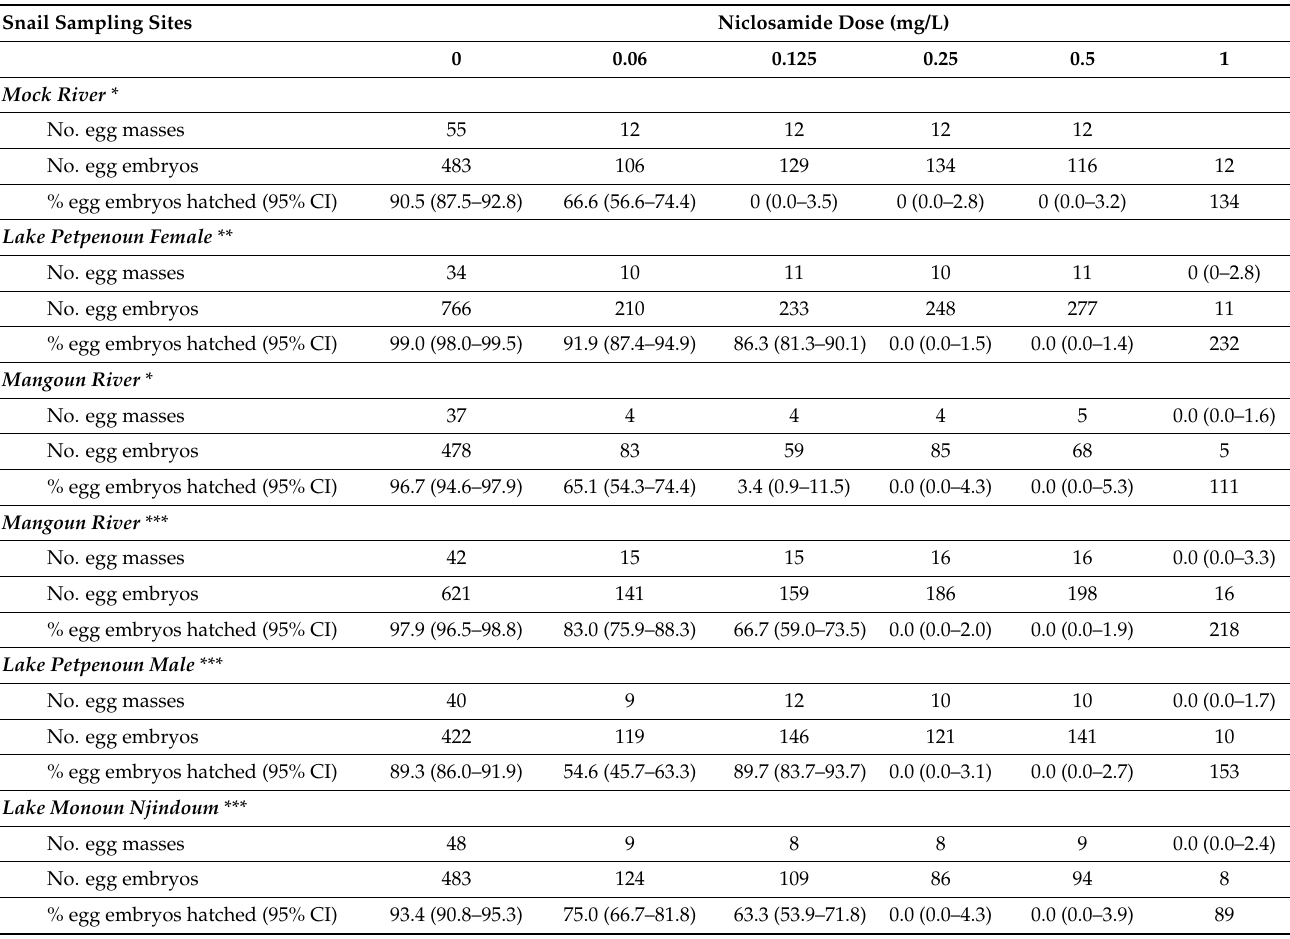
Table 1. Effect of different Niclosamide (Bayluscide WP 70) concentrations on snail egg embryos according to sampling sites and species.